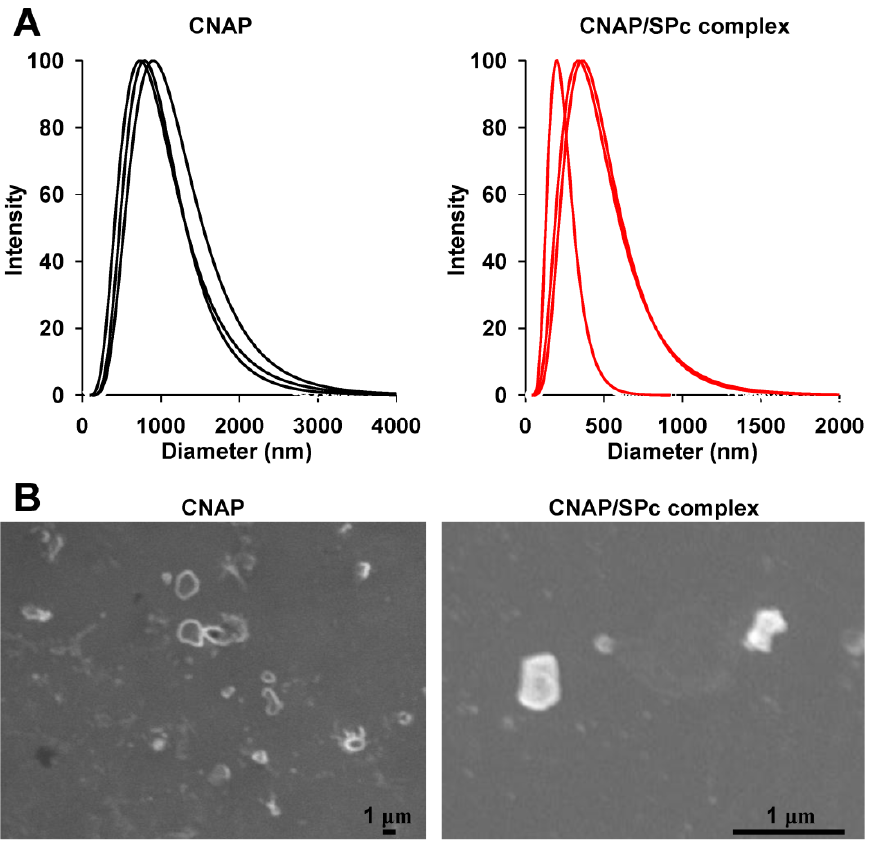
Figure 3. Particle size distributions ( A ) and SEM images ( B ) of CNAP and CNAP/SPc complex at the mass ratio of 1:1. Table 2. Reduced particle size of SPc-loaded CNAP.